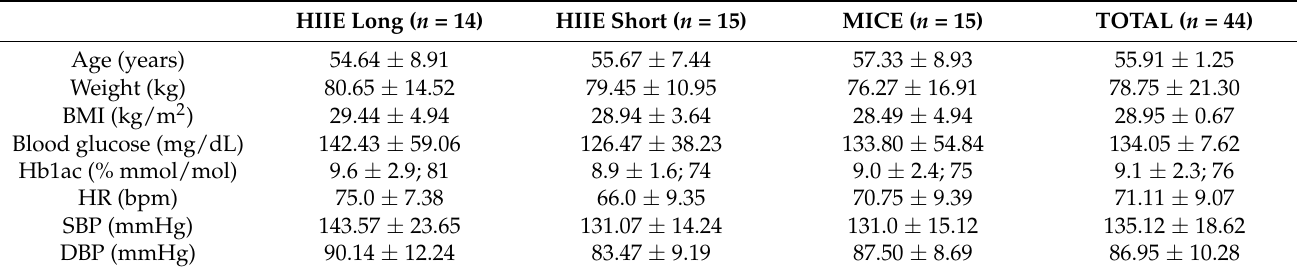
Table 1. Characteristics of patients with DM2 classified by group.